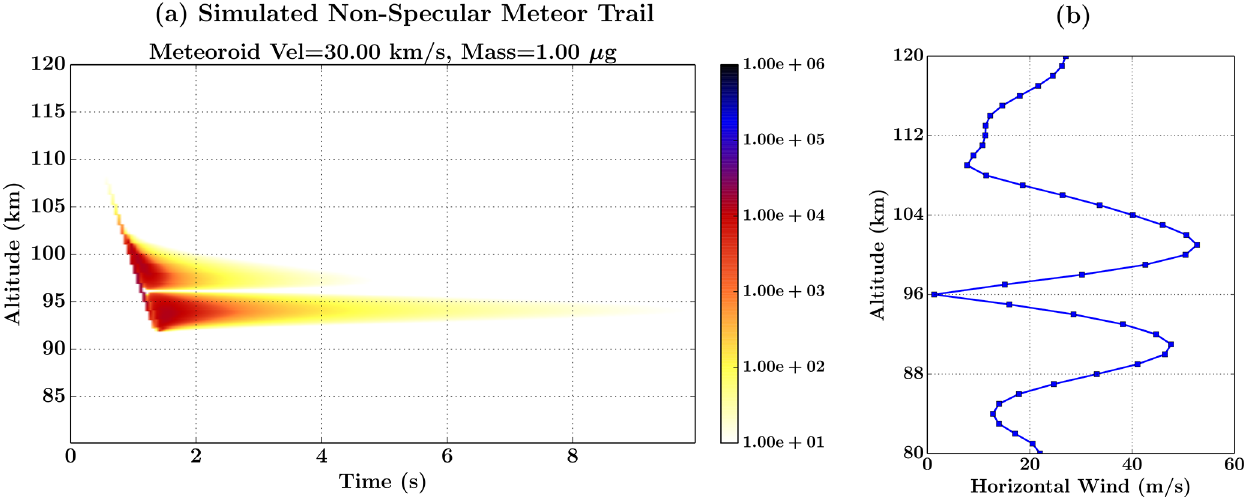
Figure 5. (a) Simulated non-specular meteor trail using a 1µg meteoroid traveling at 30kms − 1 . (b) Corresponding neutral wind vertical profile. Notice strong wind shears near 96km altitude. The absence of instabilities near 96km is most probably due to the extremely low neutral winds at this altitude. Notice that neutral wind values are very small near 96km, but its magnitude rapidly increases below or above this altitude.